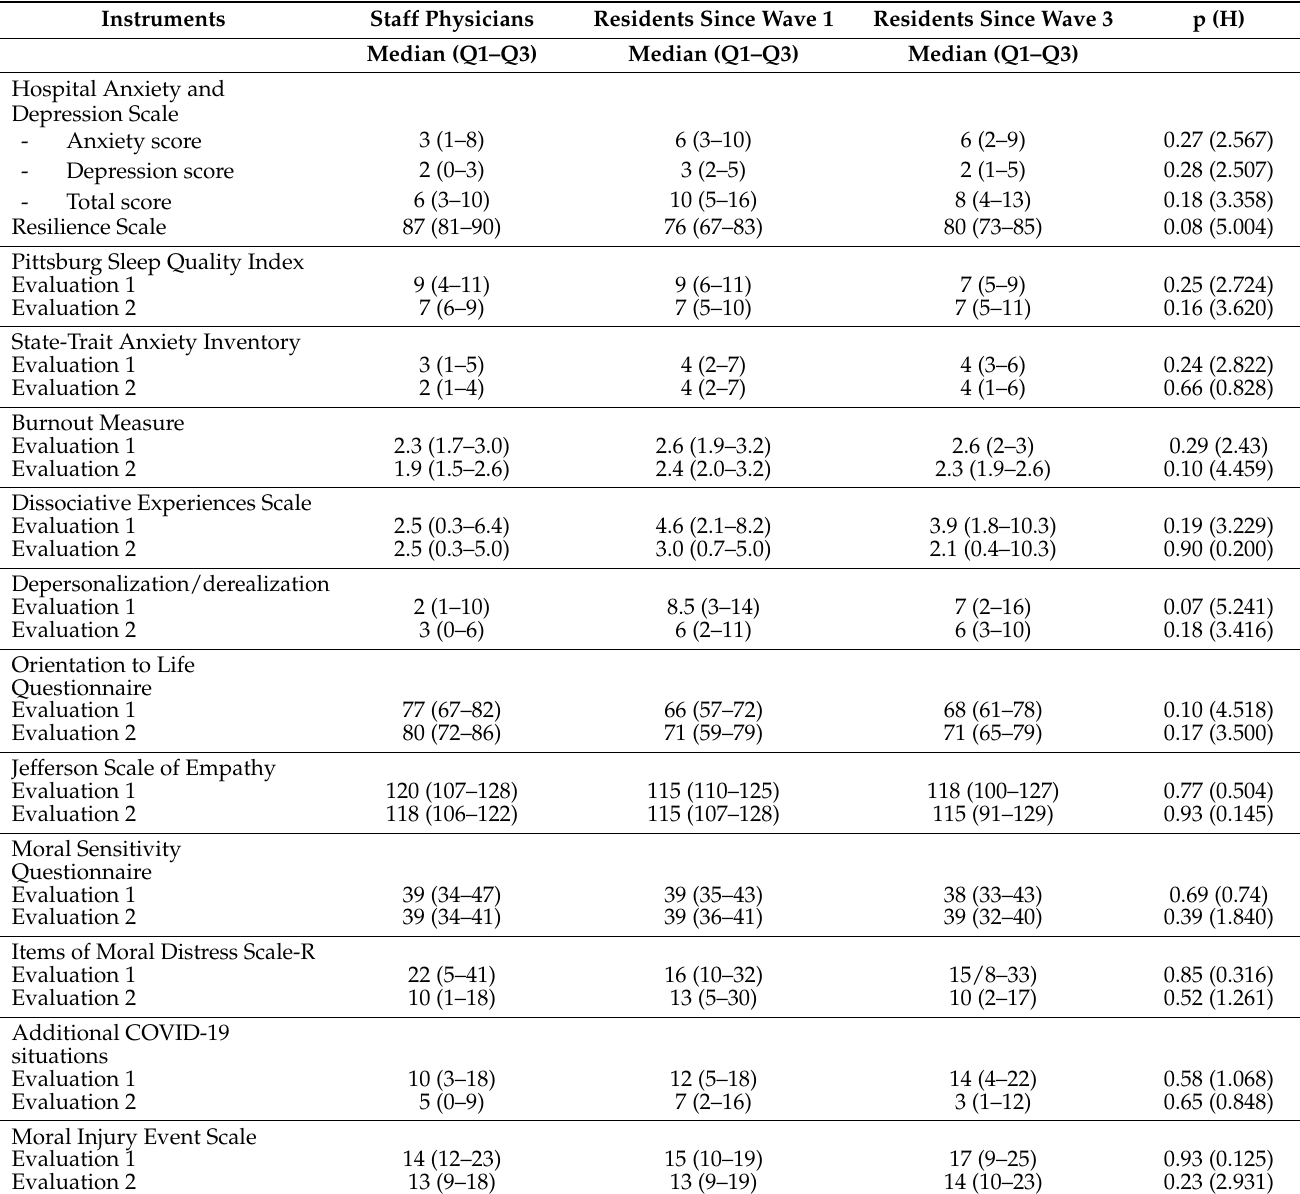
Table 2. Summary of the total scores on the assessment instruments of the 108 participants during the two evaluations, according to the experience group. Comparisons among groups were performed by Kruskal–Wallis